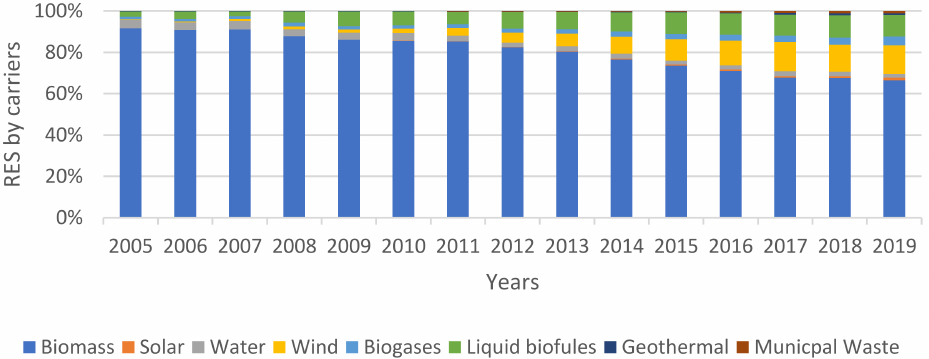
Figure 2. The structure of RES in Poland by energy carriers in 2005–2019 (%). Source: own elaboration based on [31].